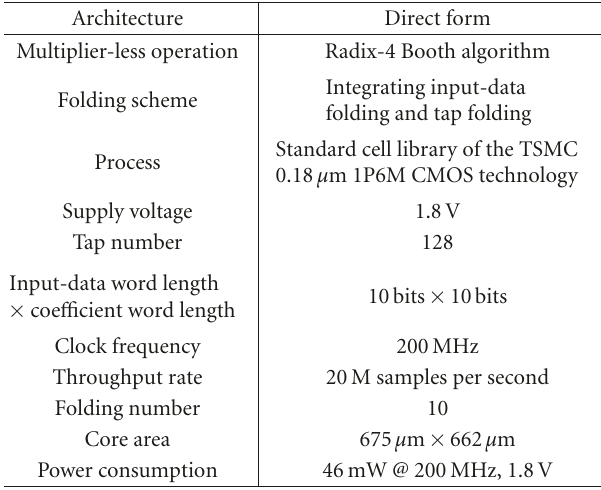
Table 2: Specification of the proposed programmable FIR proces- sor.